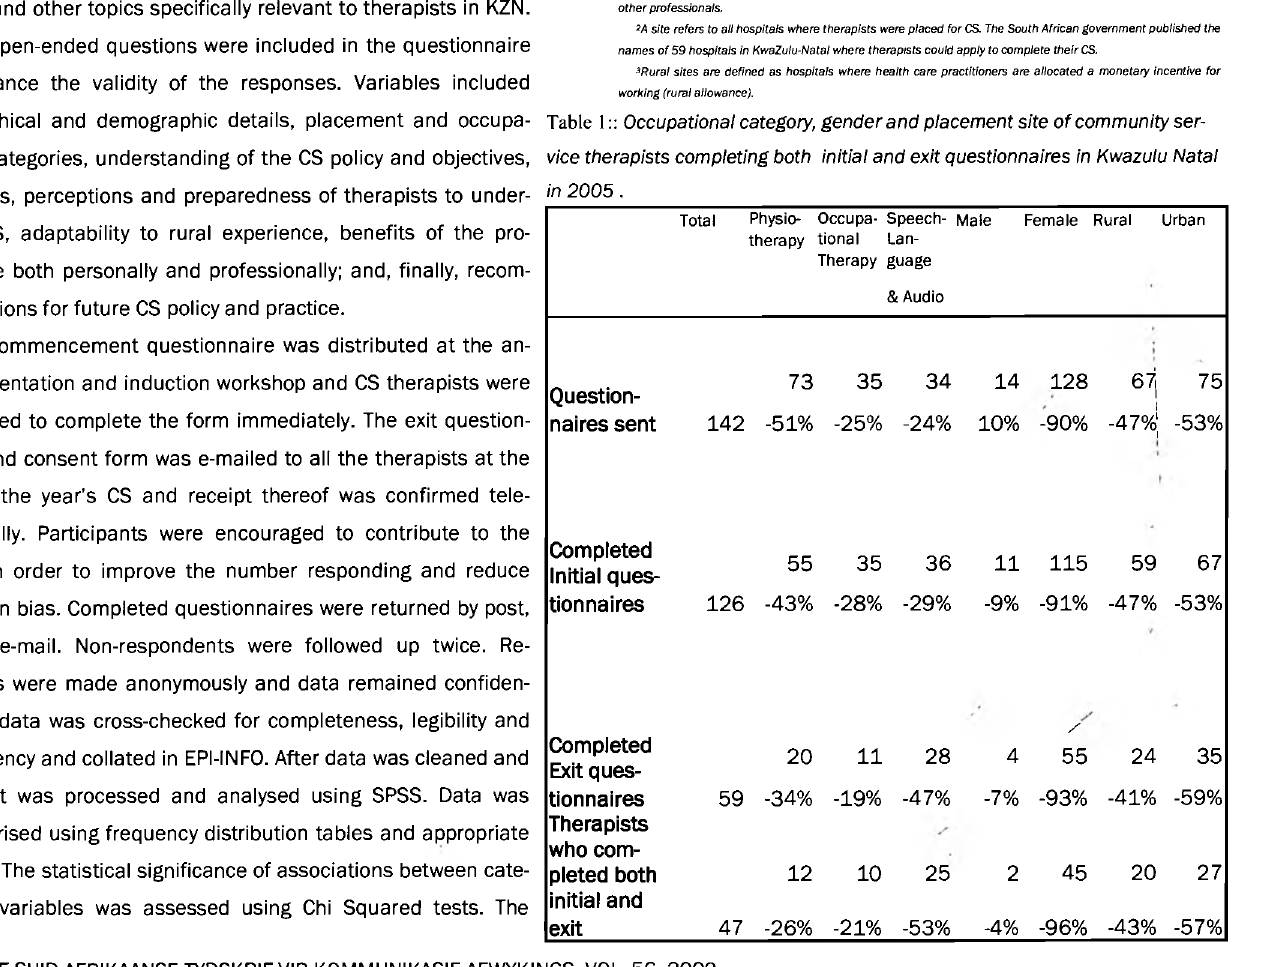
Table 1:: Occupational category, gender and placement site of community ser­ vice therapists completing both initial and exit questionnaires in Kwazulu Natal in 2005